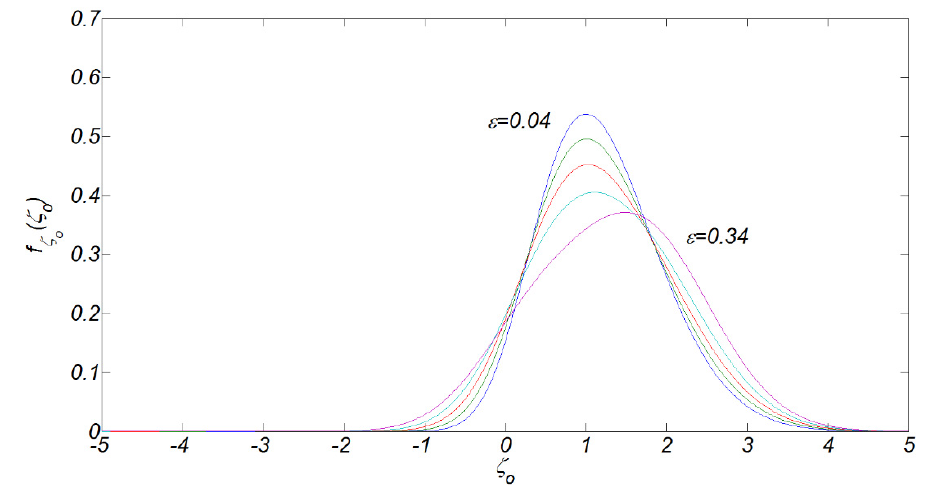
ε Figure 4. Wave crest distribution for = 0.04, 0.09, 0.15, 0.23, and 0.34 that corresponds to ξ = Figure 4. Wave crest distribution for ε = 0.04, 0.09, 0.15, 0.23, and 0.34 that corresponds to ξ = 0.005, 0.01, 0.015, 0.02, and 0.005, 0.01, 0.015, 0.02, and 0.025.